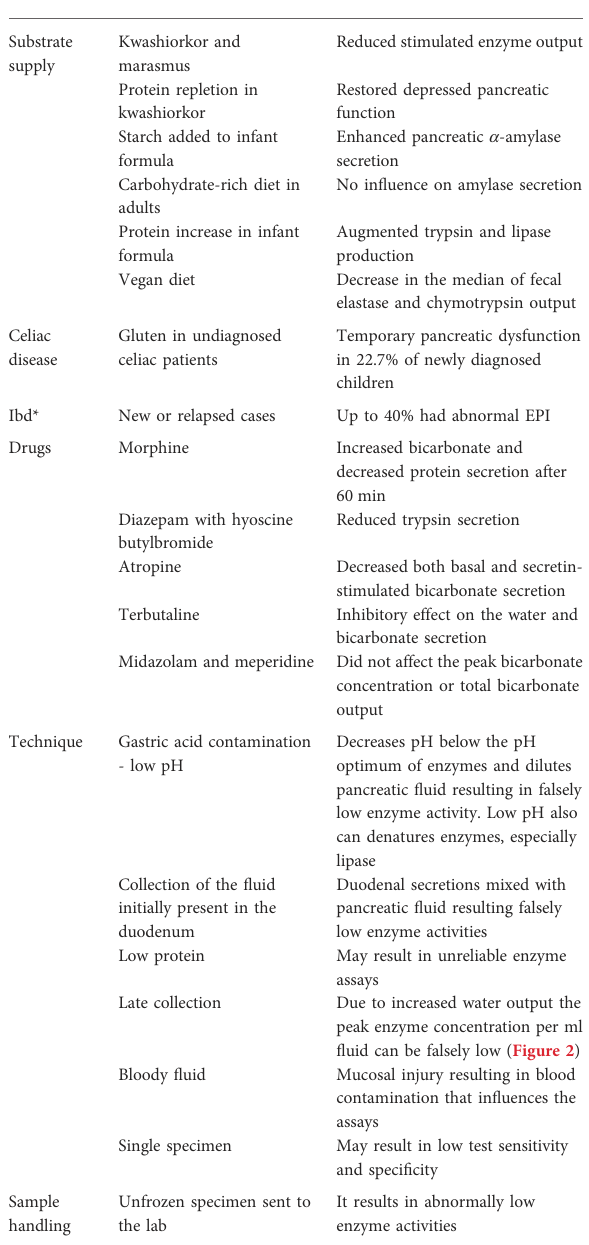
TABLE 5 Factors that have an effect on the results of ePFT (modi fi ed from